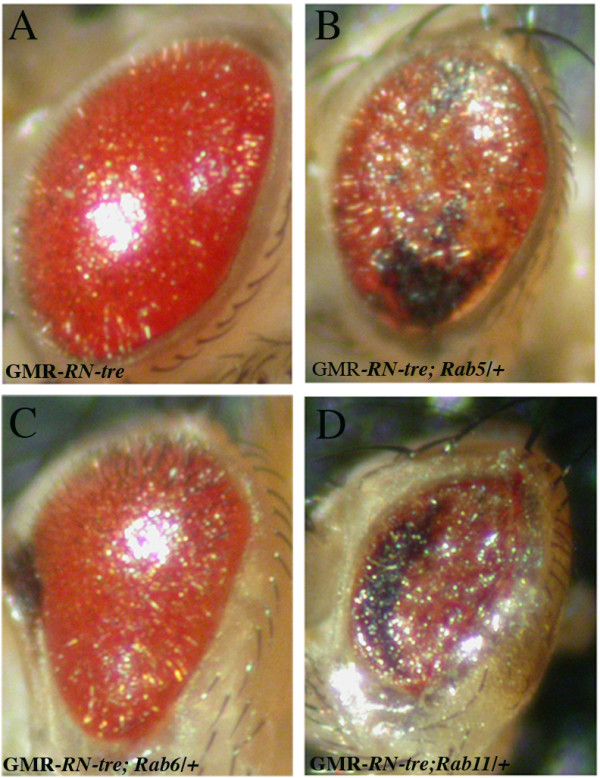
Rab5 and Rab11 mutations enhanced the RN-tre overexpression eye phenotype. (A) Ovexpression of RN-tre under control of the longGMR-GAL4 driver caused a mild rough eye phenotype. The eye appeared glassy and smooth. Genotype: UAS-RN-tre/+; longGMR-GAL4/+. (B) Reducing the dosage of Rab5 by 50% enhanced the RN-tre overexpression eye phenotype. The eye became flat and displayed a necrotic phenotype. Genotype: UAS-RN-tre/Rab52; longGMR-GAL4/+. (C) Reducing the dosage of Rab6 did not enhance the RN-tre overexpression eye phenotype. Genotype: UAS-RN-tre/Rab6D23D; longGMR-GAL4/+. (D) Reducing the dosage of Rab11 also significantly enhanced the RN-tre overexpression eye phenotype. Genotype: UAS-RN-tre/+; longGMR-GAL4/Rab11ex2.